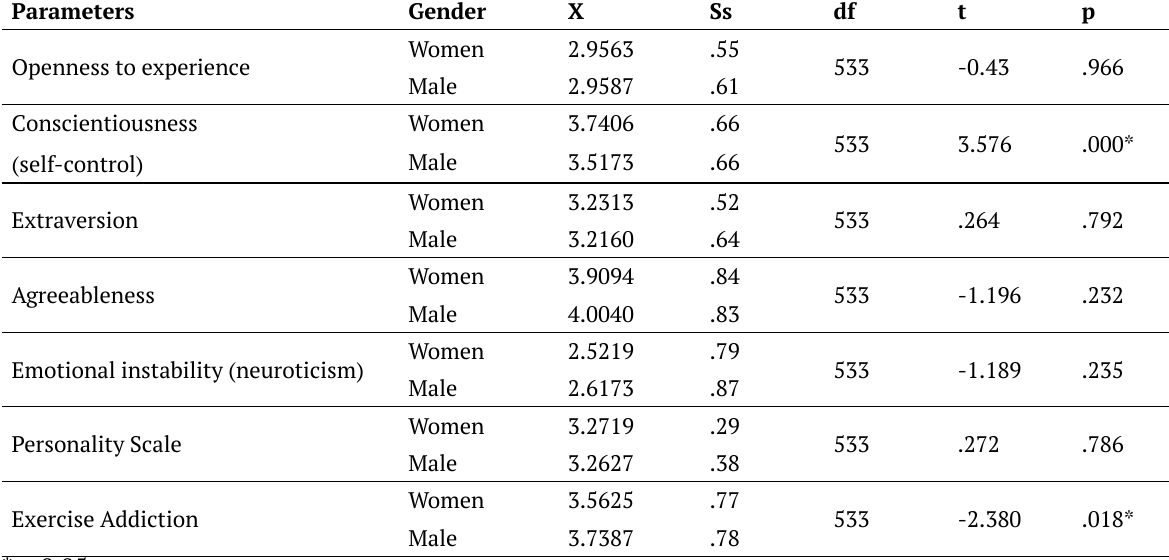
Table 2. T-test results of students’ exercise addiction and personality based on gender variable